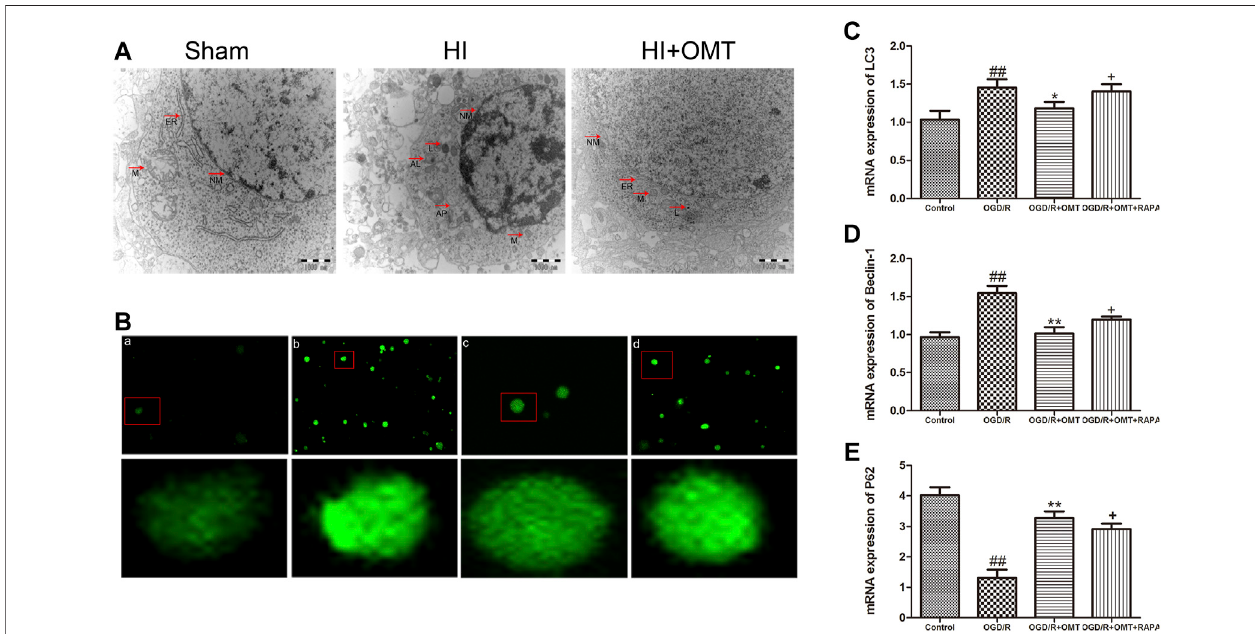
FIGURE 4 | Assessments of the level of autophagy in vivo and in vitro . (A) Transmission electron micrographs of the autophagosomes in the neonatal rats at 48 h after hypoxia-ischemia brain damage (HIBD). The arrows represent organelles and autophagosome: N, nucleus; NM, nucleus membrane; M, mitochondrion; ER, endoplasmic reticulum; L, lysosomes; and AP, autophagosome. (B) Autophagic vacuoles from each group measured by monodansylcadaverine (MDC) staining. (C – E) Levels of microtubule-associated protein 1-light chain 3 (LC3), Beclin-1 and sequestosomel (P62) mRNA in the primary hippocampal neurons measured at 24 h afteroxygen-glucosedeprivationreperfusion(OGD/R).Theresultsareexpressedasmeans ± SEM( n (cid:1) 6pergroup). ## p < 0.01vs.theshamgroup;* p < 0.05,** p < 0.01 vs. the HI group; and + p < 0.05 vs. the oxymatrine (OMT) group.